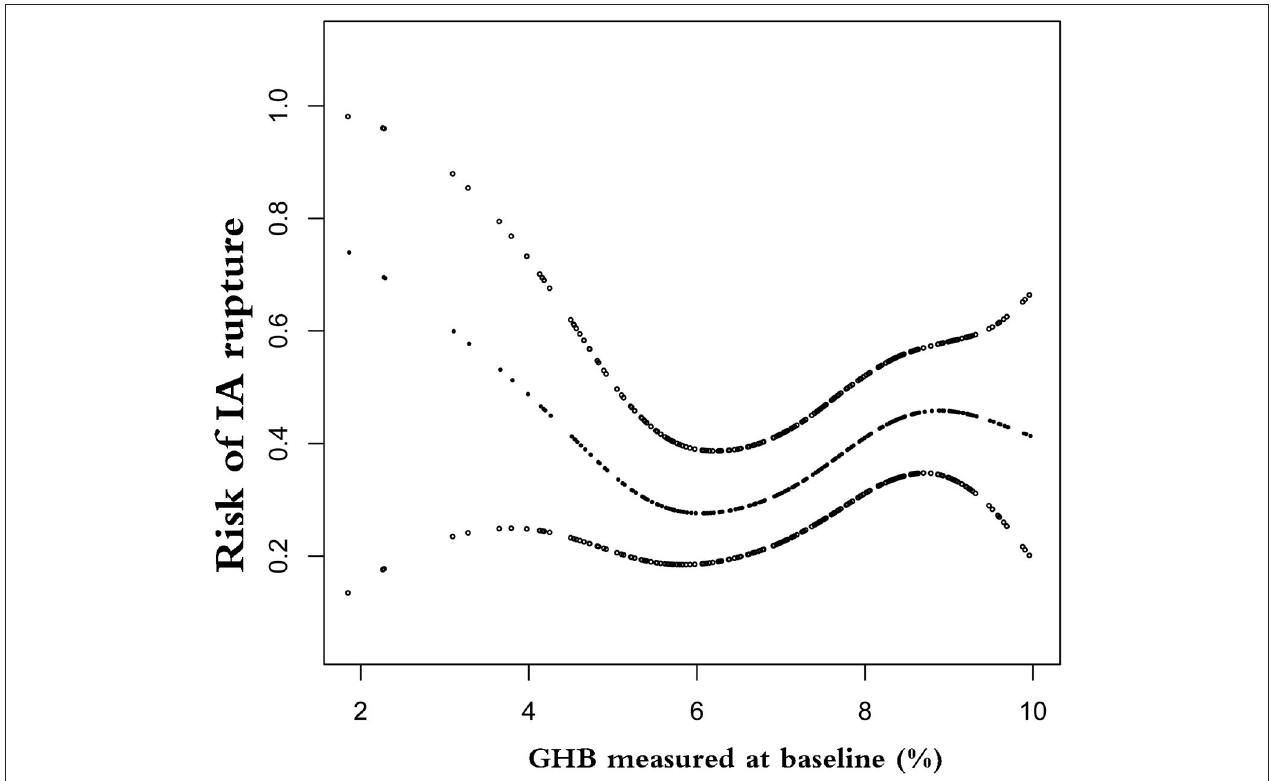
FIGURE 1 | Nonlinear relationship between glycosylated hemoglobin (GHB) and risk of intracranial aneurysm (IA) rupture. The horizontal axis on the graph is the value of GHB, and the vertical axis is the risk of IA rupture.